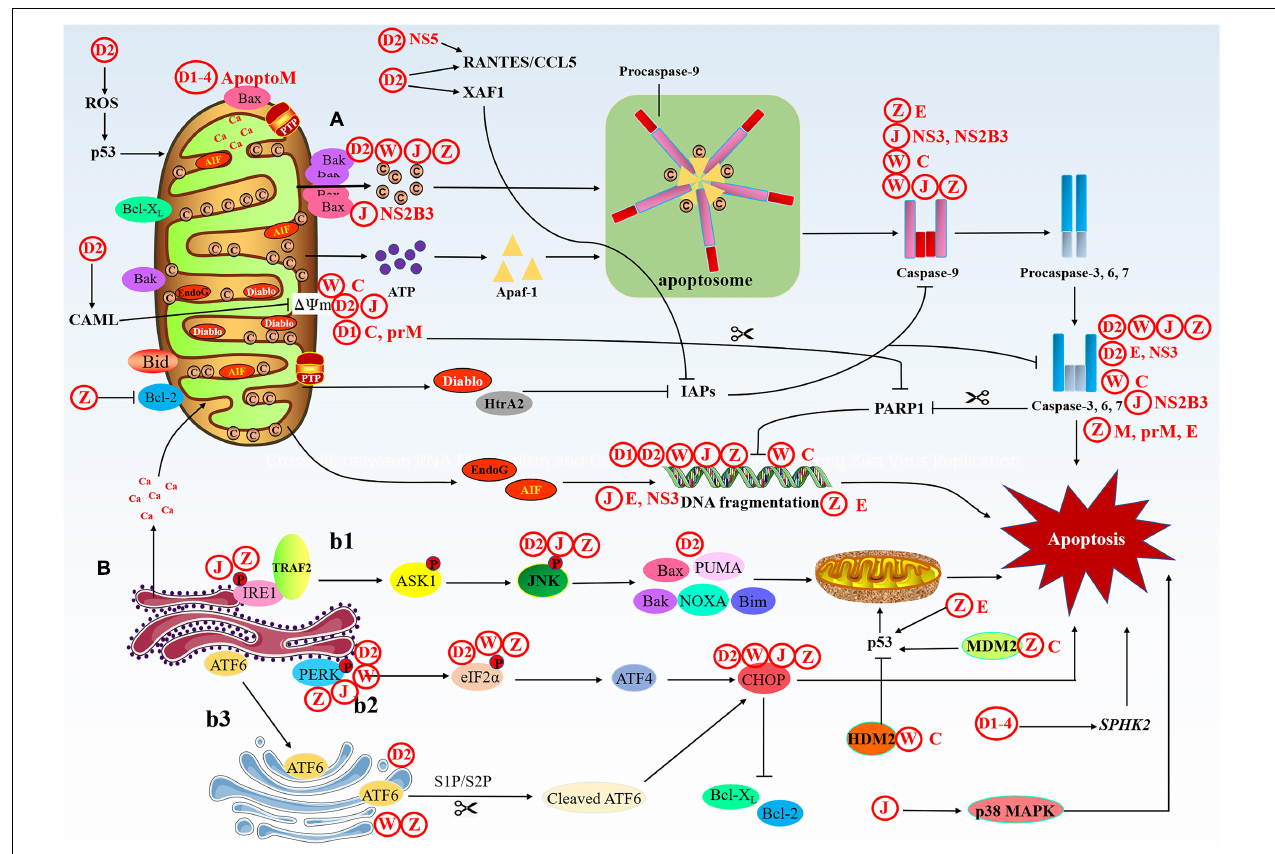
FIGURE 3 | The intrinsic apoptotic pathway. The intrinsic cell death pathway is activated by an intracellular death signal. (A) This signal results in the oligomerization and translocation of Bak and Bax into the outer membrane of the mitochondria. This triggers mitochondrial outer membrane permeabilization (MOMP) and the release of Cyt-c and IAP binding proteins. Cyt-c forms a complex with pro-caspase-9 and Apaf-1, leading to activation of caspase-9, then caspase-9 activates the executioner caspases (caspase-3, -6, and -7) and induces cell death. The IAP binding proteins, such as Diablo and HtrA2, enhance caspase activation through the neutralization of IAPs. (B) Under ER stress, three upstream signaling proteins, IRE1, PERK, and ATF6, are activated, thus leading to a cascade of activity that induces apoptosis. (b1) The prolonged activation of IRE1 can promote apoptosis. Phosphorylated IRE1 recruits TRAF2 and triggers a cascade of phosphorylation events, such as the activation of ASK1, which ultimately phosphorylates and activates JNK. Then, JNK phosphorylation activates pro-apoptotic genes and induces apoptosis through the mitochondrial pathway. (b2) The homomultimerization and autophosphorylation of PERK leads to eIF-2 α phosphorylation, which increases the translation of ATF4. Then, ATF4 upregulates the expression of CHOP, which promotes apoptosis. (b3) ATF6 migrates to the Golgi apparatus to undergo cleavage, first by S1P and then by S2P, cleaved ATF6 can also promote apoptosis via upregulation of